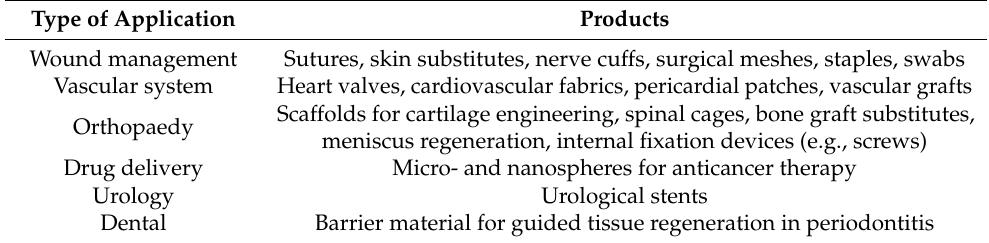
Table 6. Applications of PHA in medicine [9]. Type of Application Products Wound management Sutures, skin substitutes, nerve cuffs, surgical meshes, staples, swabs Vascular system Heart valves, cardiovascular fabrics, pericardial patches, vascular grafts Scaffolds for cartilage engineering, spinal cages, bone graft substitutes, Orthopaedy meniscus regeneration, internal fixation devices (e.g., screws) Drug delivery Micro- and nanospheres for anticancer therapy Urology Urological stents